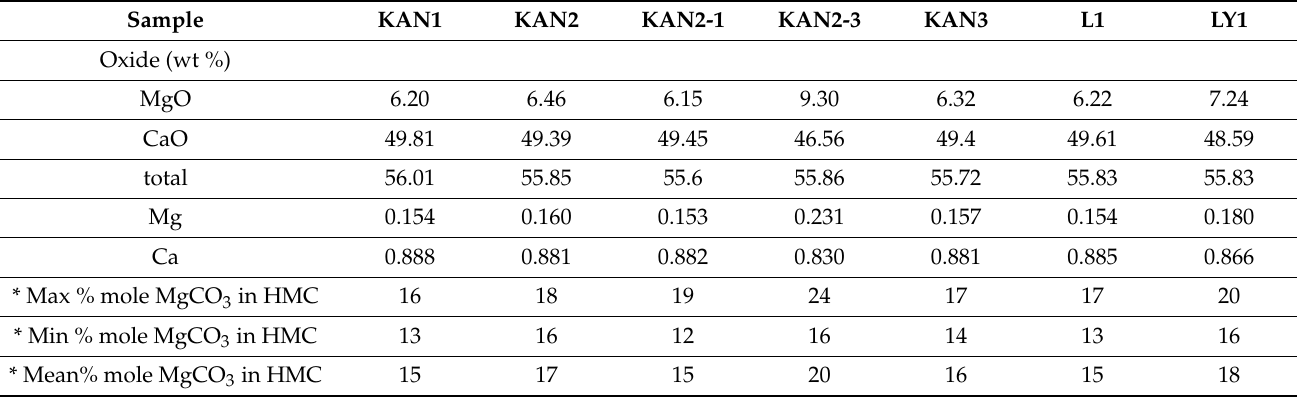
Table 2. Representative micro analysis of cement in studied samples and the respect % mole MgCO 3 in calcite lattice.